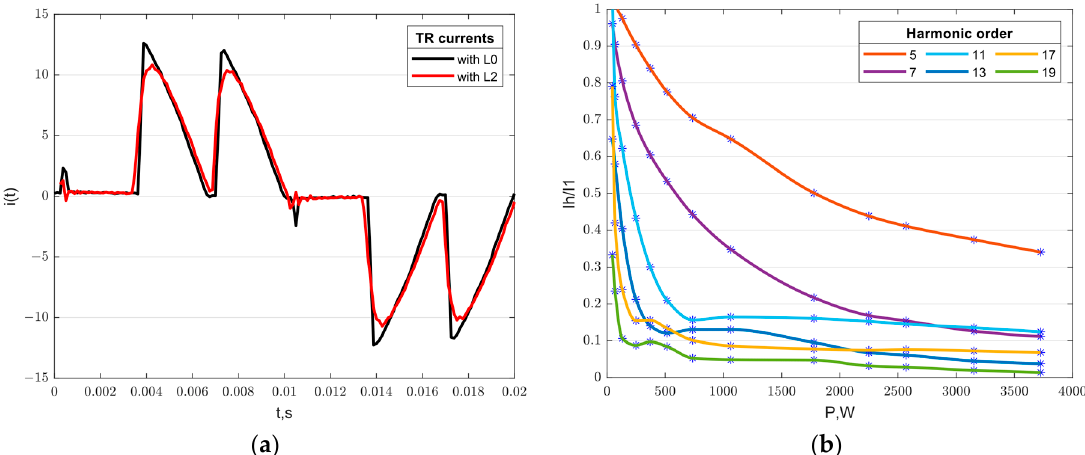
Figure 4. Waveforms of the TR currents at various values of the grid inductance ( a ); relative values of the TR harmonic currents for different power consumption ( b ).